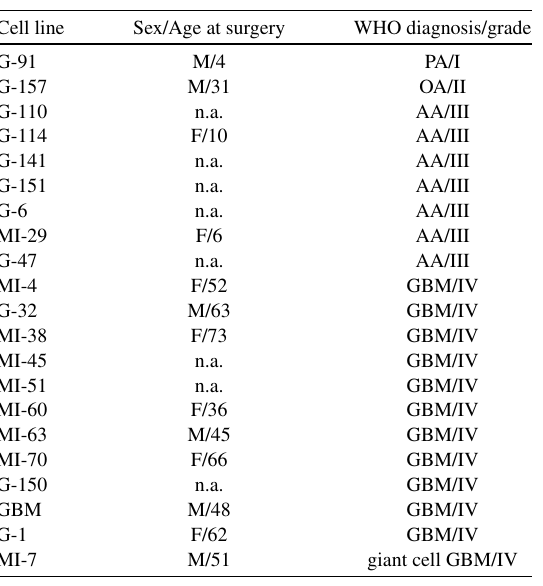
Set of 21 investigated primary glioma cell lines Cell